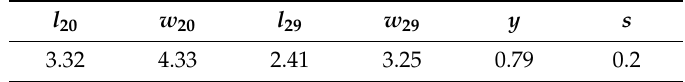
Figure 2. Dual frequency microstrip antenna structure (main patch and outer structure) using a PIN diode and two bias circuits. diode and two bias circuits. Table 1. Main dimensions of the designed microstrip antenna structure (in Table 1. Main dimensions of the designed microstrip antenna structure (in mm).